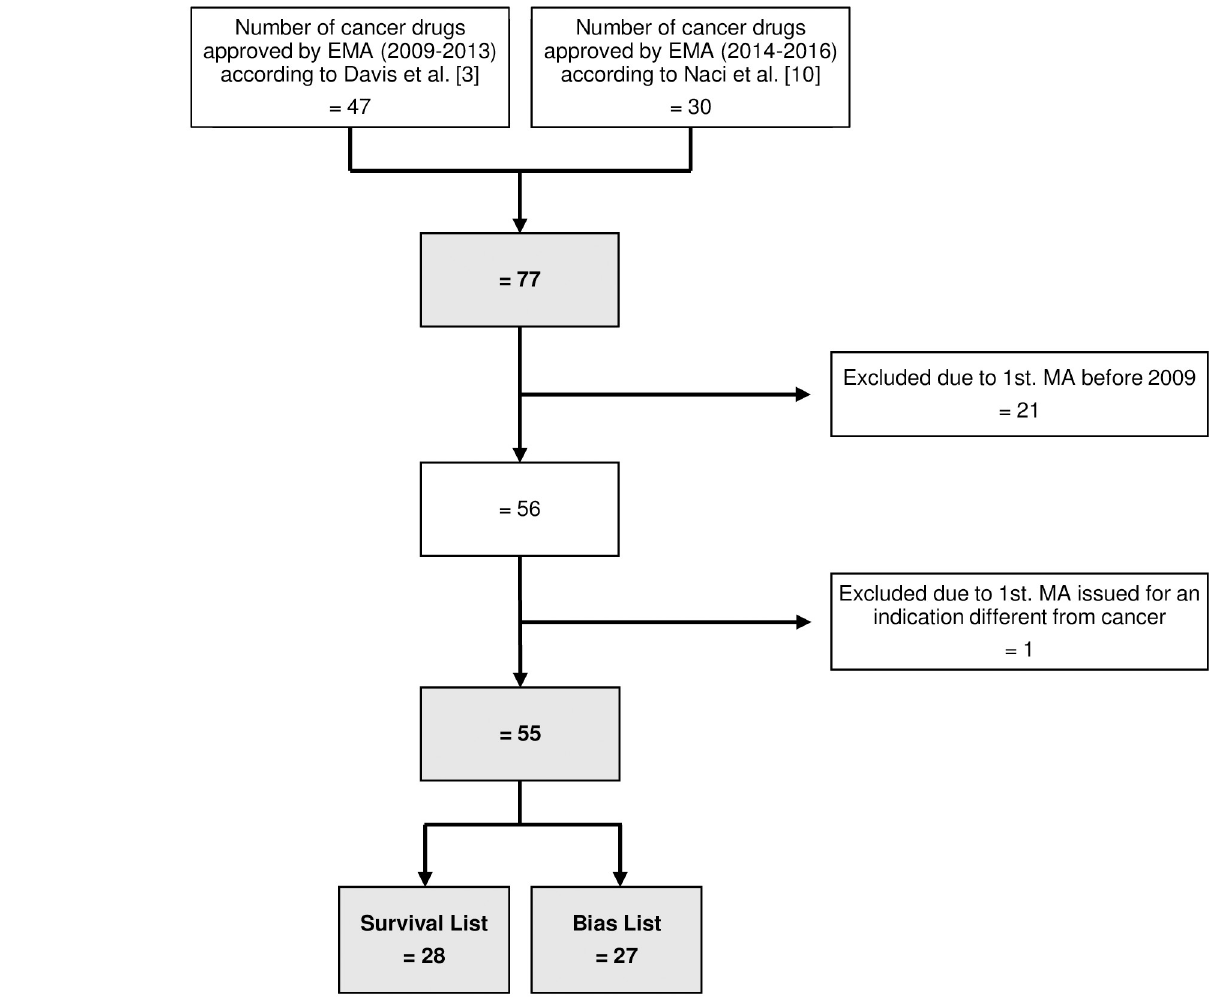
Fig 1. Selection of cancer